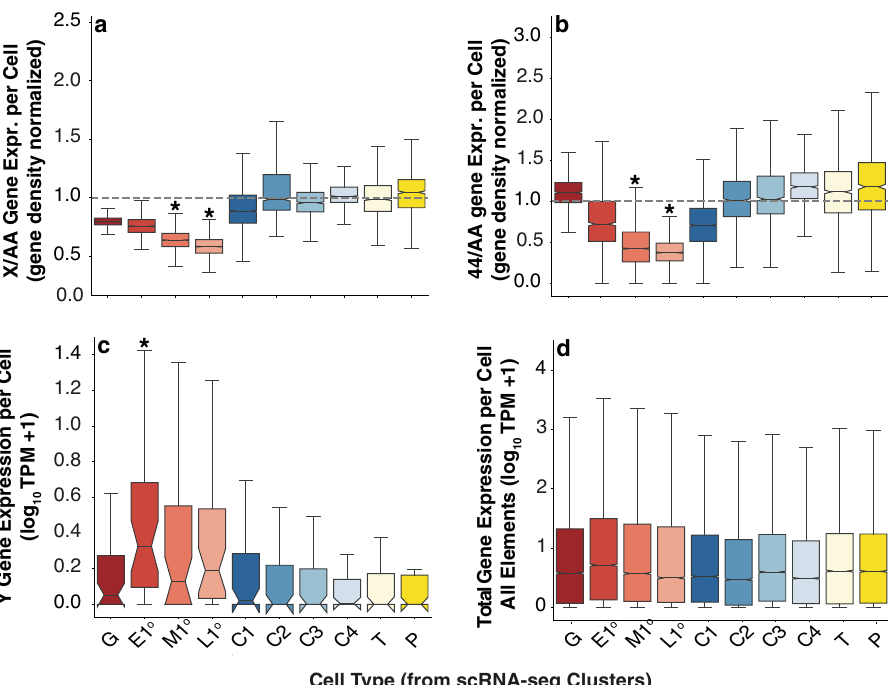
Fig. 3 X-, 4th-, and Y-linked gene expression patterns across cell types. Cell type-speci fi c gene expression of a X-linked genes and b 4th-linked genes scaled by major autosomal element gene expression (2nd and 3rd chromosomes) at cellular resolution [e.g., (X TPM/ #X Genes)/(A TPM/ # A Genes). c Y-linked gene expression and d genome-wide expression in normalized read counts. Chromosomal distributions in germ cells, signi fi cantly different from somatic cell types, are indicated with an asterisk ( a , b p ≤ 0.01 using permutation test, c : q -value ≤ 0.01 using χ 2 test). a – d The number of cells scored are: G = 1065, E1 = 1267, M1 = 4570, L1 = 2667, C1 = 4064, C2 = 1230, C3 = 910, C4 = 945, T = 1379, P = 868. Boxplots (box = interquartile range (IQR), notch = 95% con fi dence interval of median, whiskers = ± 1.5xIQR).